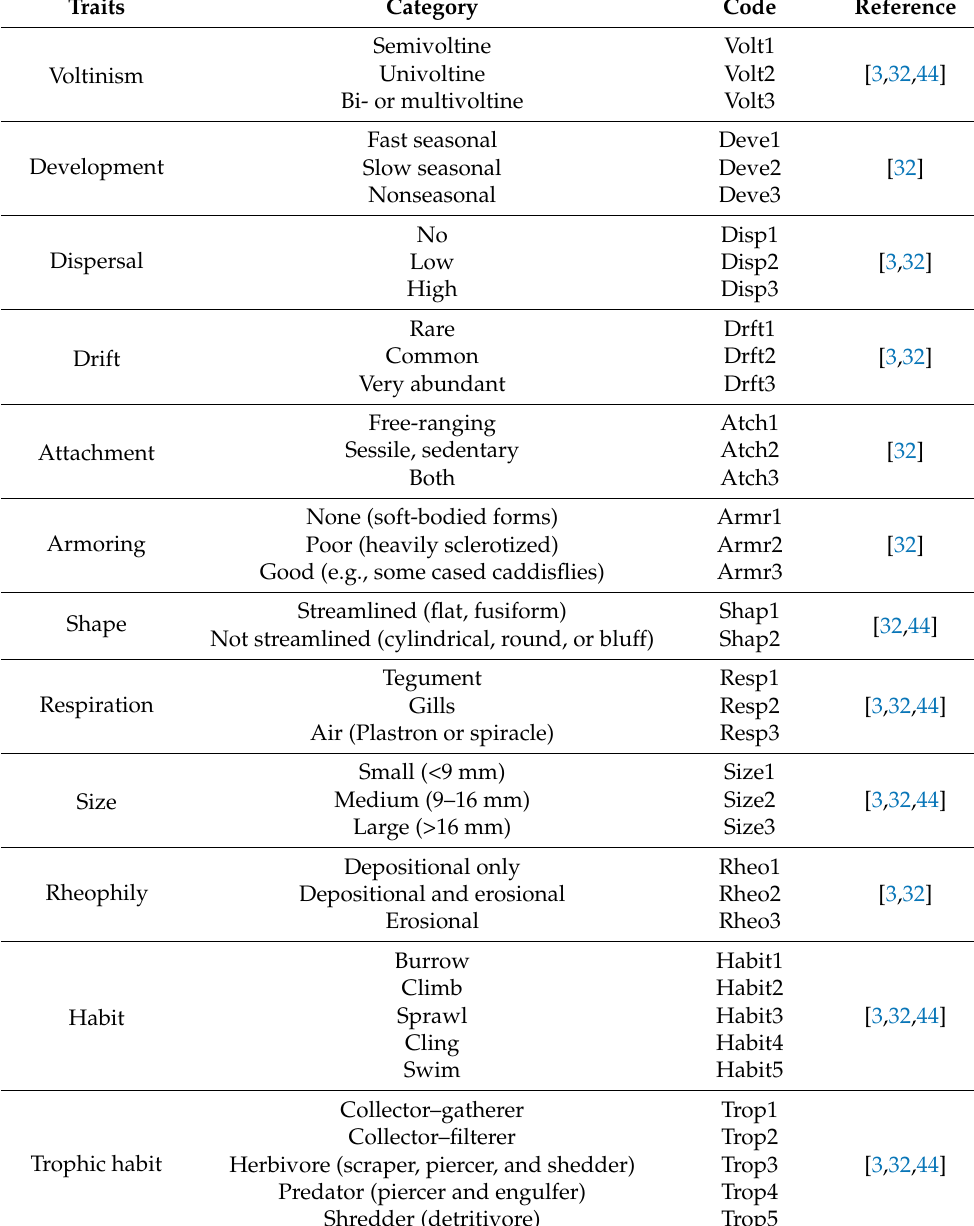
Table 1. Macroinvertebrate traits and categories of used in the assessment of the trait–environment relationships across three different land use types in the present